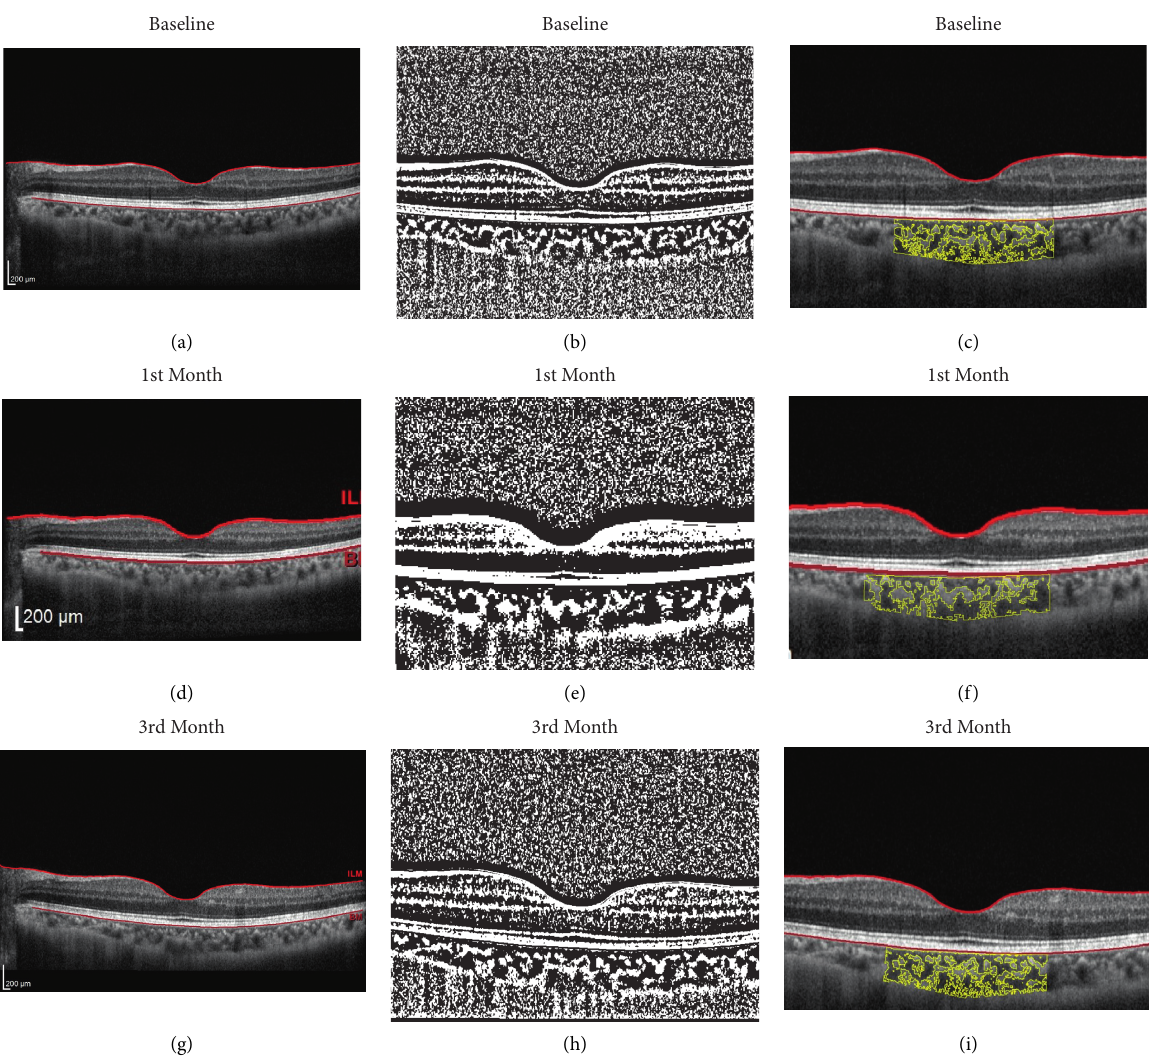
Figure 1: Choroidal vascular index (CVI). The first column (a–c) shows the baseline visit of a patient. The second (d–f) and third (g–i) columns relate to the same person in the first and third visits. To calculate CVI, the image was converted to 8 bits and the brightness was set at the measure of the average of three 9-micron lumens of blood vessels. Corneoscleral junction was determined. The image was binarized using Niblack auto local threshold (the middle rows). The area was added to the ROI tool. Then, the image was converted to the RGB, and the color threshold tool was used for thresholding the image. The area was added to ROI; another time was with the AND tool. The selected area was measured as the luminal area (LA). In the last rows between the yellow areas, the grey zones represent the LA and the bright zones demonstrate the stromal area. The CVI was calculated by dividing LA by the total choroidal